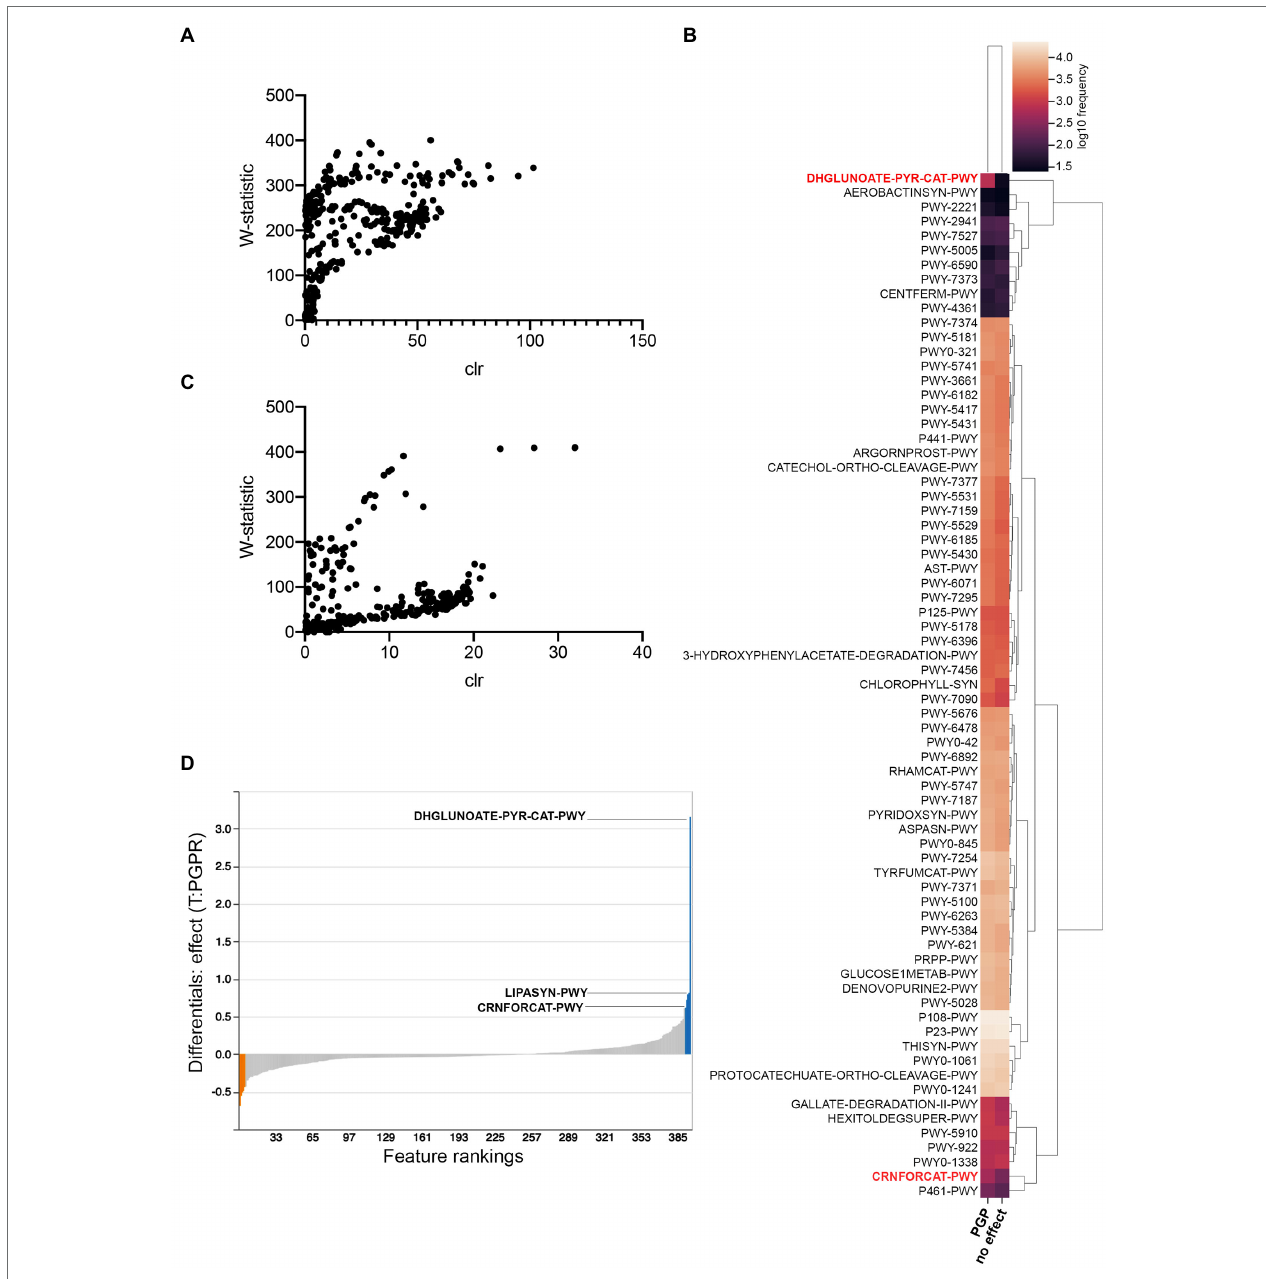
FIGURE 7 | PICRUSt2 predicted pathway variations in plant-growth-promoting treatments compared to those with no effect. (A) ANCOM analysis in Promix (B) Heatmap of ANCOM output in Promix of relative abundance of pathways between treatments having a plant-growth-promoting effect and no effect (pathways in red have been identified by both ANCOM and Songbird) (C) ANCOM analysis in Canna coco (D) Songbird analysis in Promix. In blue are the top pathways associated with plant growth promotion and in orange the pathways least associated with this